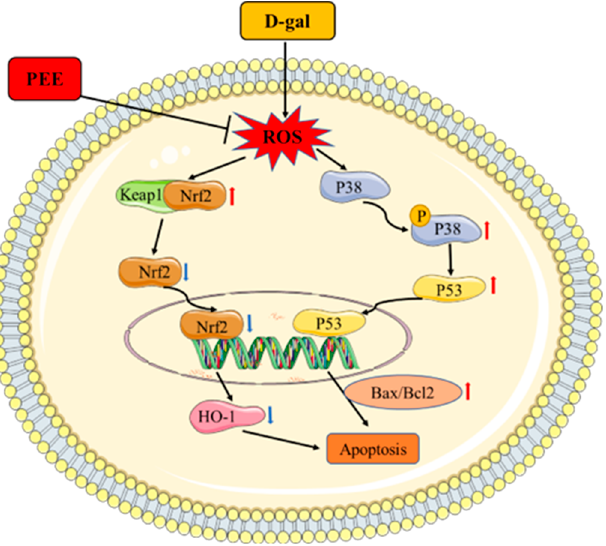
Figure 6. The protective mechanism of PEE on D-gal induced C2C12 cell injury.